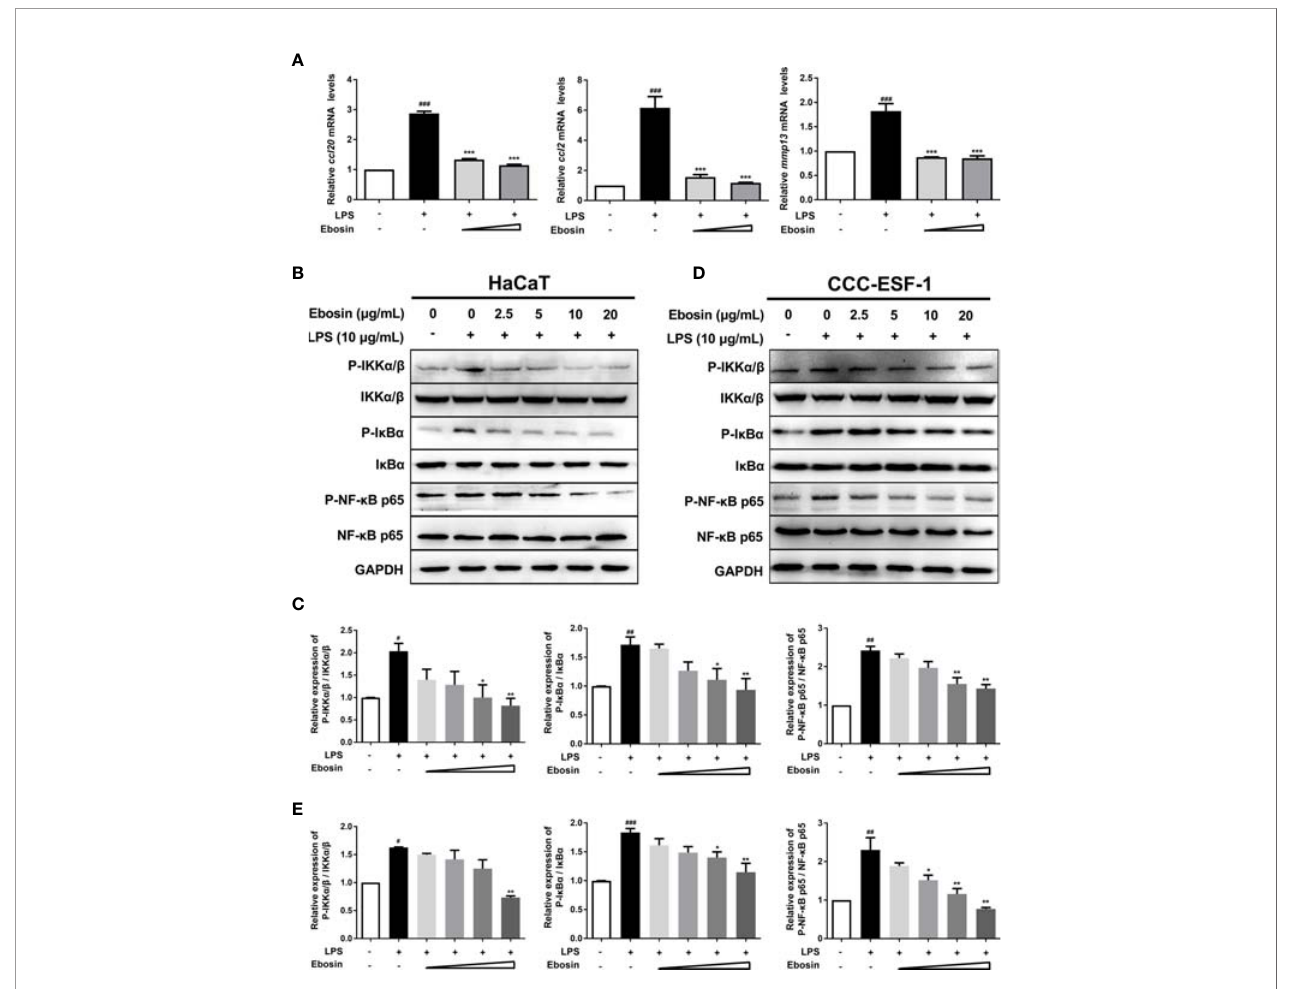
FIGURE 1 | Effects of Ebosin on LPS-induced HaCaT and CCC-ESF-1 cells. (A) RT-PCR analyses of genes in HaCaT cells, including ccl-20 , ccl-2 , and mmp13 (mean ± SD, n = 3). (B, C) Western blotting analyses for proteins on IKK/NF- k B signaling pathway in HaCaT cells. (D, E) Western blotting analyses for proteins on IKK/NF- k B signaling pathway in CCC-ESF-1 cells. # P < 0.05, ## P < 0.01, ### P < 0.001 vs. control; * P < 0.05, ** P < 0.01, *** P < 0.001 vs. LPS-induced